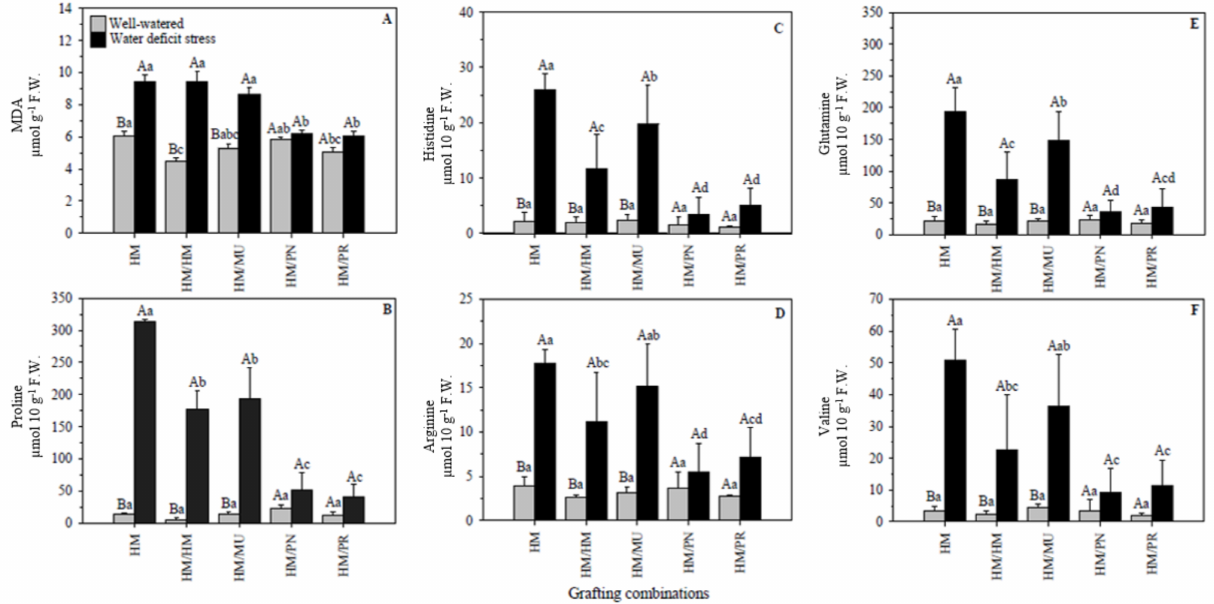
Figure 6. ( A ) Malondialdehyde (MDA) and ( B ) proline, ( C ) histidine, ( D ) arginine, ( E ) glutamine, and ( F ) valine of five grafting combinations under well-watered and water-deficit stress conditions. Capital letters denote significant differences between the water regimes within each graft combination and lower-case letters denote significant differences among grafting combinations within each water regime according to the LSD test ( p ≤ 0.05). Columns are mean ± standard error. Note: HM = non-grafted HM 1823; HM/HM = HM 1823 self-grafted; HM/MU = HM 1823 grafted onto Multifort; HM/PN = HM 1823 grafted onto S. pennellii ; and HM/PR = HM 1823 grafted onto S. peruvianum